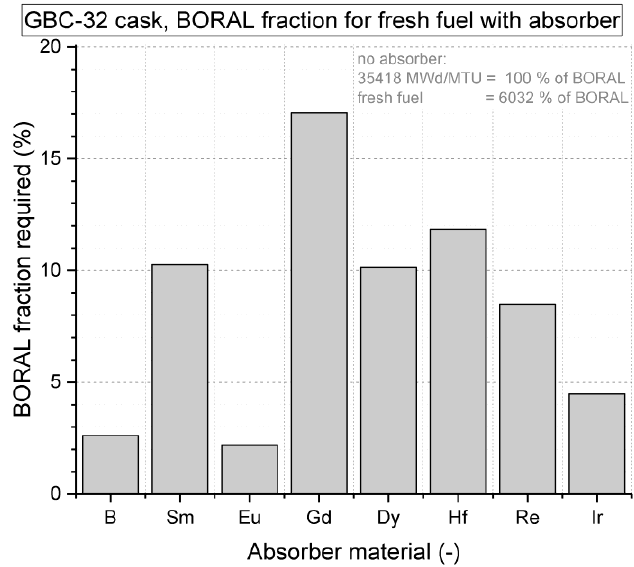
Figure 6. Decreasing boron content in BORAL sheets when improved absorbers are